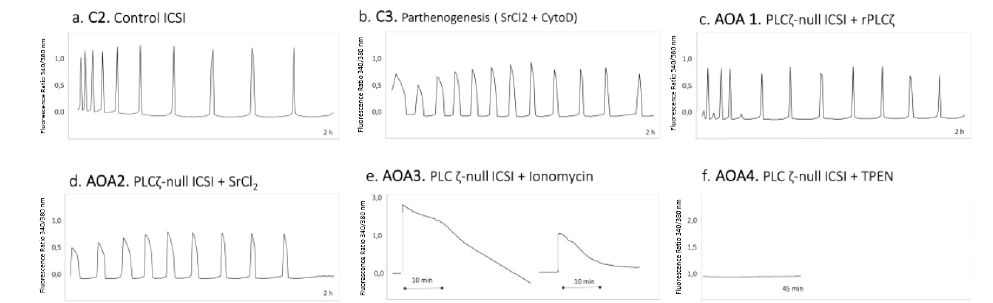
Figure 5. Representative Ca 2 + signaling responses registered after in vitro fertilization in mouse oocytes in combination with di ff erent assisted oocyte activation methodologies. ( a ) Physiological Ca 2 + oscillation pattern obtained after an injection of wild-type sperm into mouse oocytes (Control 2). ( b ) Ca 2 + oscillation pattern observed after the parthenogenetic activation of mouse oocytes using SrCl 2 in combination with Cytochalasin D (Control 3). ( c – f ) In order, Ca 2 + oscillation patterns obtained after injection of PLC ζ -null sperm in combination with rhPLC ζ (AOA1), SrCl 2 (AOA2), Ionomycin (AOA3), and the Zn 2 + chelator TPEN (AOA4). Reproduced from Minerva et al., 2020 with permission